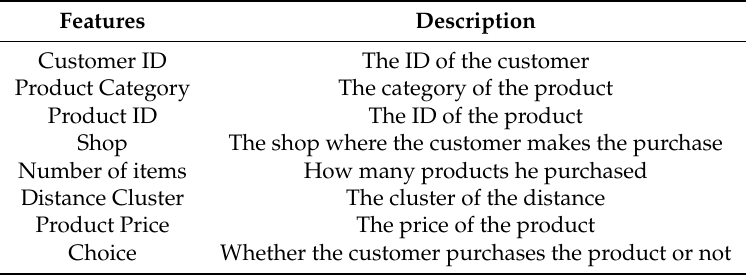
Table 1. Training set